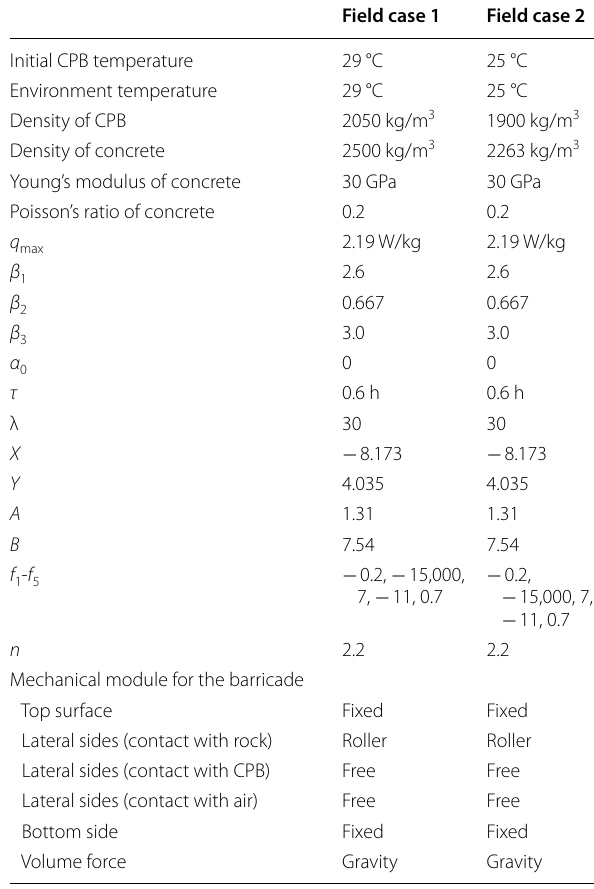
Table 1 Input parameters, boundary conditions and initial values used for validating the developed model.